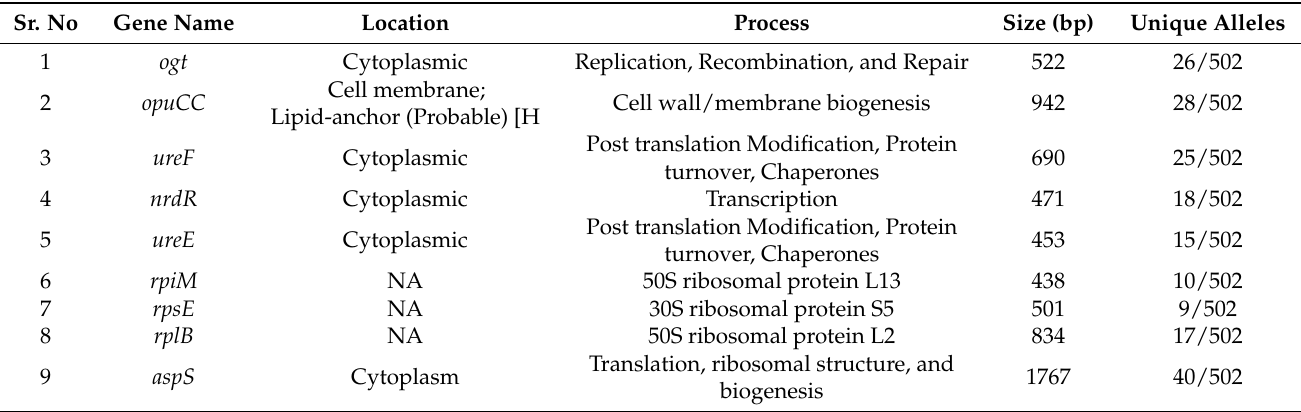
Figure 7. Proposed MLST scheme. The figure shows old, recommended genes and the new proposed gene candidates. The initial shortlisting included 130 candidate genes in the unrepresented region, which were further evaluated for their suitability as candidates for the MLST scheme as manifested in Table 4. Table 4. Shortlisted gene candidates based on exclusion–inclusion criteria. The table represents the properties of the shortlisted gene candidates that are based on exclusion–inclusion criteria. Sr .